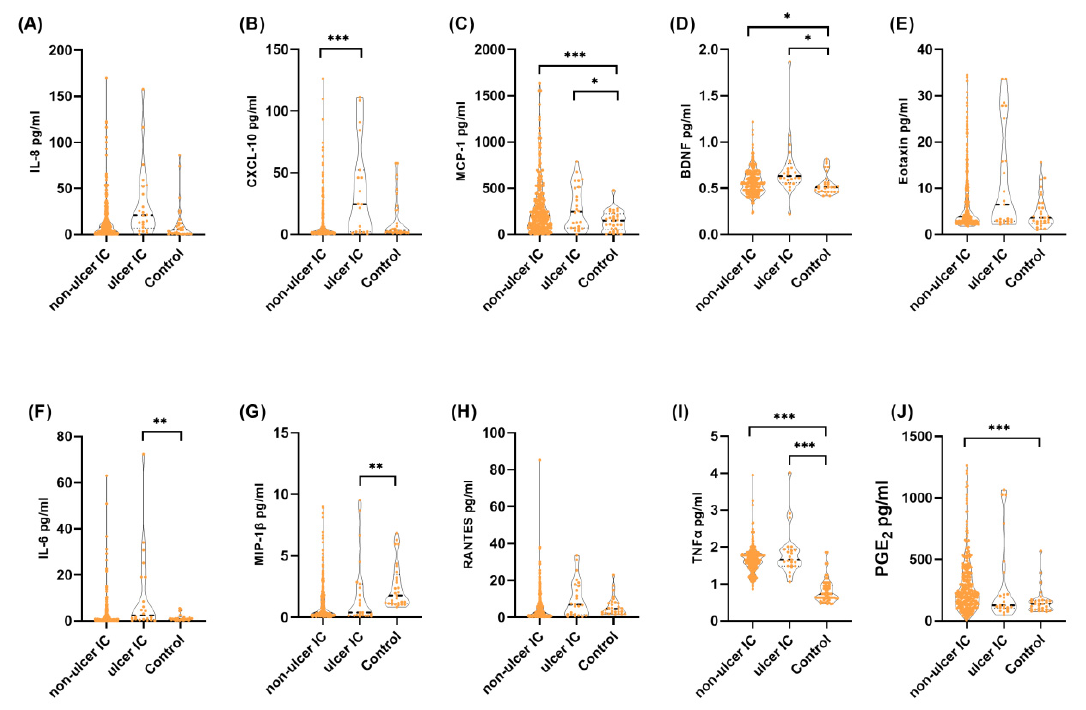
Figure 2. Violin plots of the levels of urine biomarkers among different subgroups of patients with IC/BPS and controls. Urine levels of ( A ) IL-8; ( B ) CXCL10; ( C ) MCP-1; ( D ) BDNF; ( E ) eotaxin; ( F ) IL-6; ( G ) MIP-1 β ; ( H ) RANTES; ( I ) TNF- α , and ( J ) PGE2. Among the biomarkers, MCP-1, eotaxin, MIP-1 β , TNF- α , and PGE2 were significantly higher in total IC/BPS patients than controls. Among IC/BPS patients, IL-8, CXCL10, BDNF, IL-6, and RANTES were significantly higher in patients with HIC than non-HIC patients. * p < 0.05, ** p < 0.01, *** p < 0.001. BDNF, brain-derived neurotrophic factor; CXCL10, C-X-C motif chemokine ligand 10; eotaxin, eotaxin-1; HIC, Hunner’s interstitial cystitis; IC/BPS, interstitial cystitis/bladder pain syndrome; IL-, interleukin-; MCP-1, monocyte chemoattractant protein-1; MIP-1 β , macrophage inflammatory protein-1 beta; PGE2, prostaglandin E2; RANTES, regulated upon activation, normally T-expressed, and presumably secreted; TNF- α , tumor necrosis factor-alpha. Table 2. The urine biomarkers among IC/BPS subgroup patients with different maximal bladder capacity and Hunner’s IC patients. Urine Bi- omarkers @